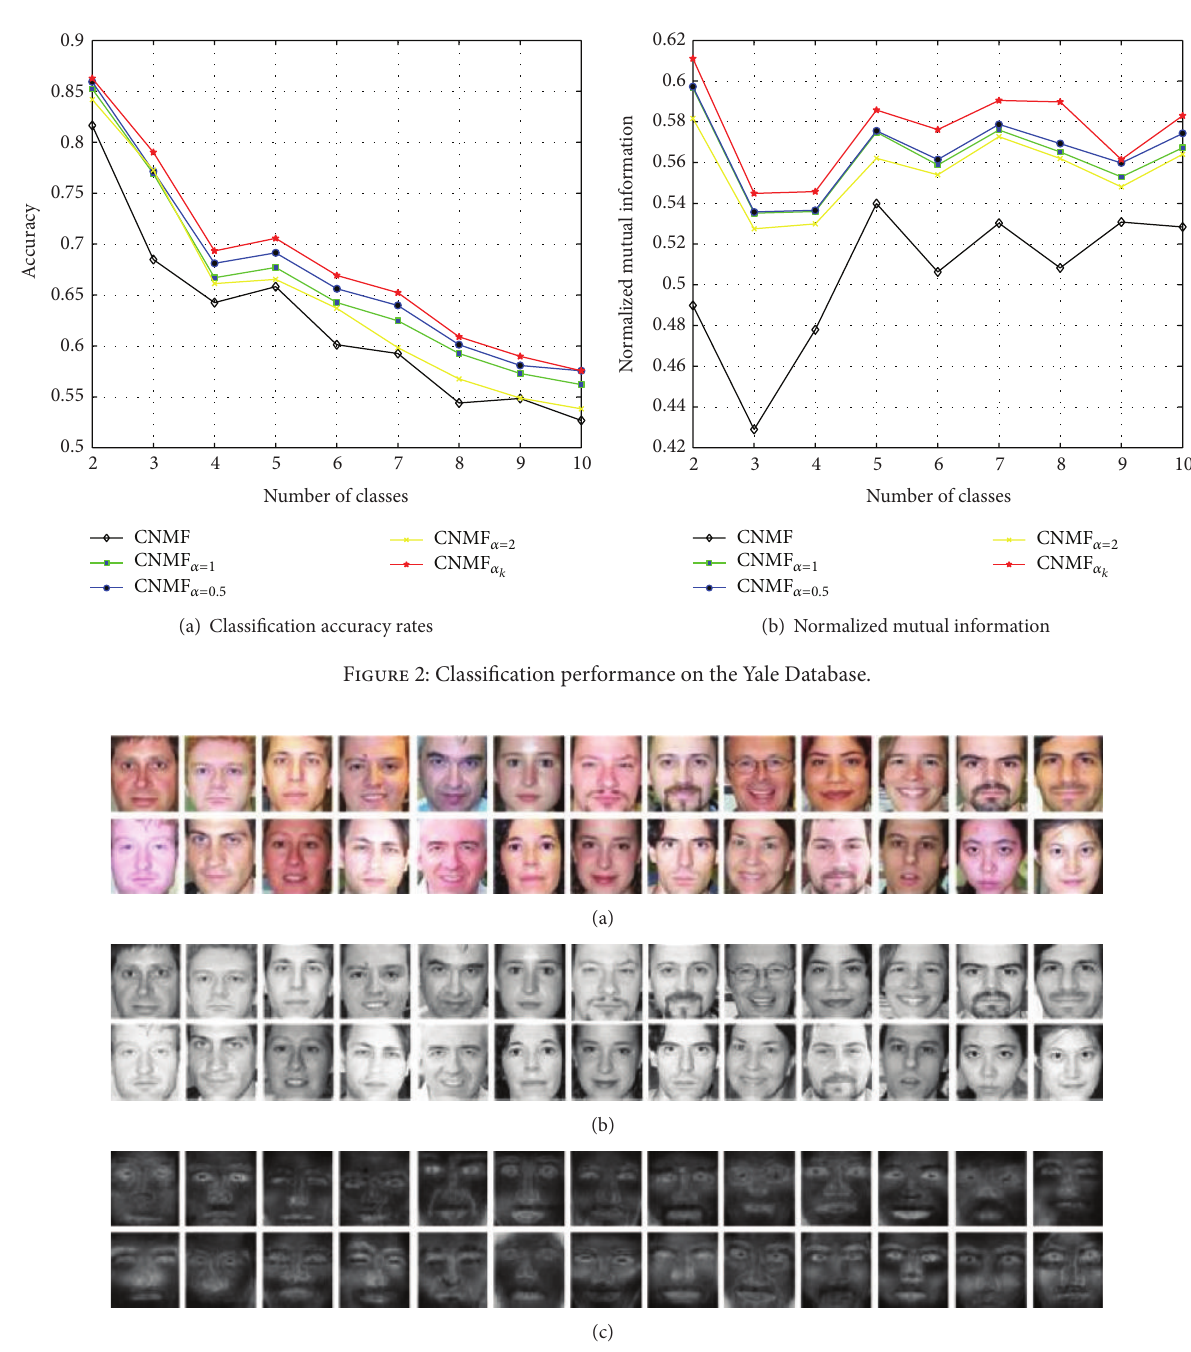
Karush-Kuhn-Tucker conditions and presented